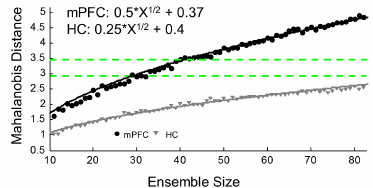
Figure 2. Coding Schemes of the medial prefrontal cortex (mPFC) and hippocampus (HC). Information content by ensemble size. This analysis compares the separation in higher dimensional space between the neural representations of two distinct spatial environments. In these sessions, animals spent time in two empty open field environments and this analysis examines how neuronal ensembles responded to the change in environments. To create this plot, neuronal firing rates from last 200 s in environment A were compared to activity from the first 200 s in environment B from all mPFC and HC sessions, respectively, were combined to create four matrices. Then, n neurons (range = 10–83) were randomly selected (without replacement within draws and with replacement between draws) and the Mahalanobis distance between environment periods was calculated using the same randomly drawn neurons for both periods. This process was repeated 100 times for each ensemble size. The x -axis shows the size of each ensemble and the y -axis is the mean of the Mahalanobis distances between environments for each step. Lines show the fit lines as defined by the inset equations. mPFC values are in black and HC are grey. The green dotted lines show the mean ± standard error of the mean Mahalanobis distance from the original mPFC “no-task” session ensembles. mPFC ensembles contain a much more distributed coding scheme of unique environments. The mPFC fit slope is substantially steeper and even ensembles of over 80 HC neurons have between environment distances less than the original mPFC session mean minus the SEM. The analyses presented here were performed on data first reported in [19]. Please see the original article for methodological